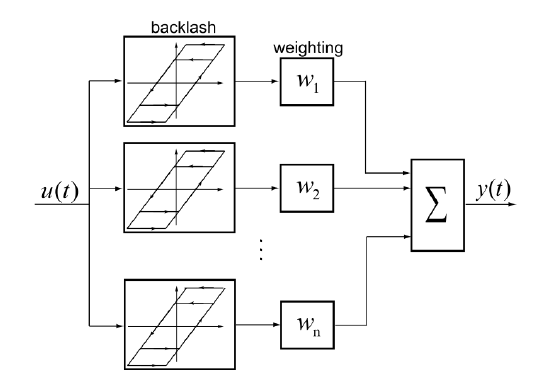
Figure 1. Working principles of the PI hysteresis